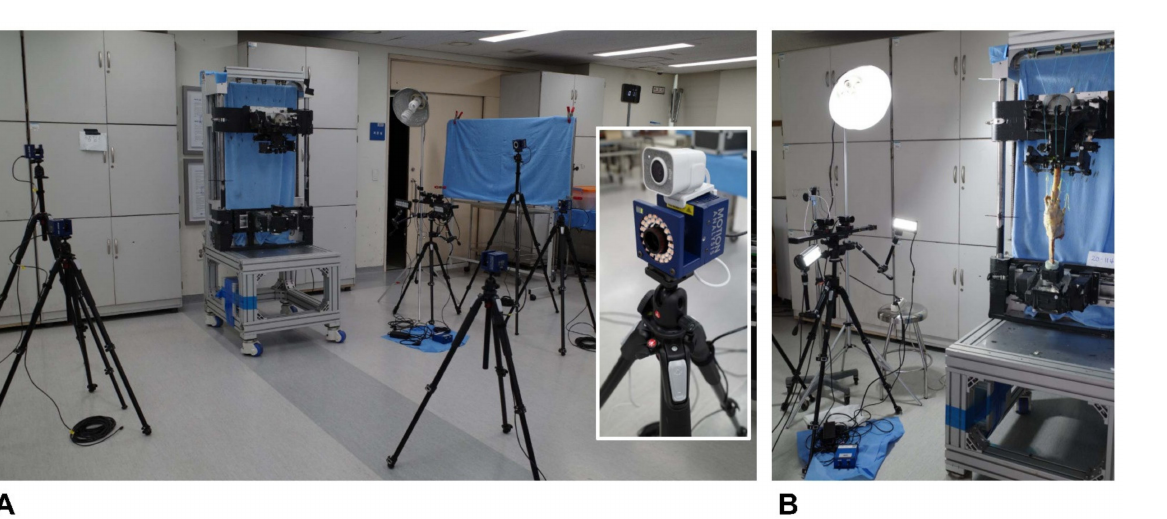
Figure 3. Biomechanical test setup. The motion capture system included five cameras; optical markers were placed when measuring knee kinematics ( A ). Real-time changes in MCL strain during flexion were analyzed using a noncontact video extensometer with a high-resolution digital camera and real-time image-processing software. A camera was placed 1 m from each specimen mounted in a customized knee-squatting simulator ( B